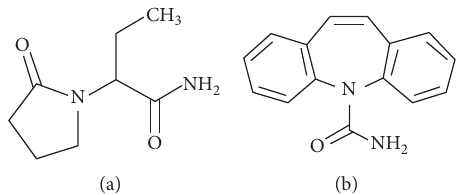
Figure 1: Chemical structures: (a) levetiracetam and (b) carbamazepine